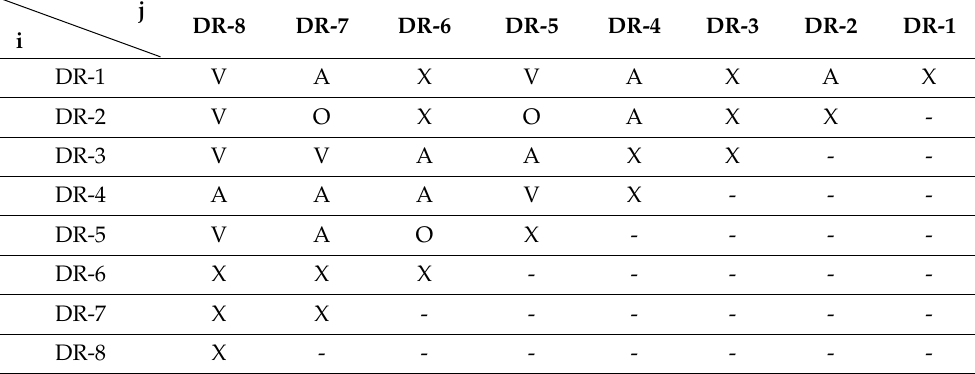
Table 1. SSIM of the drivers.